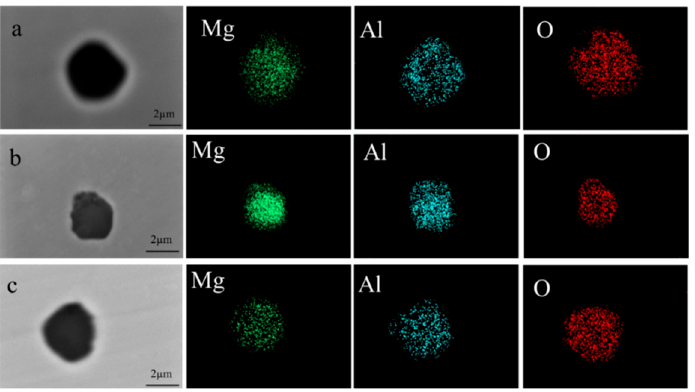
Figure 2. The composition distribution diagram of the inclusions in the sample. ( a ) sample M1, ( b ) sample M2, ( c ) sample M2.